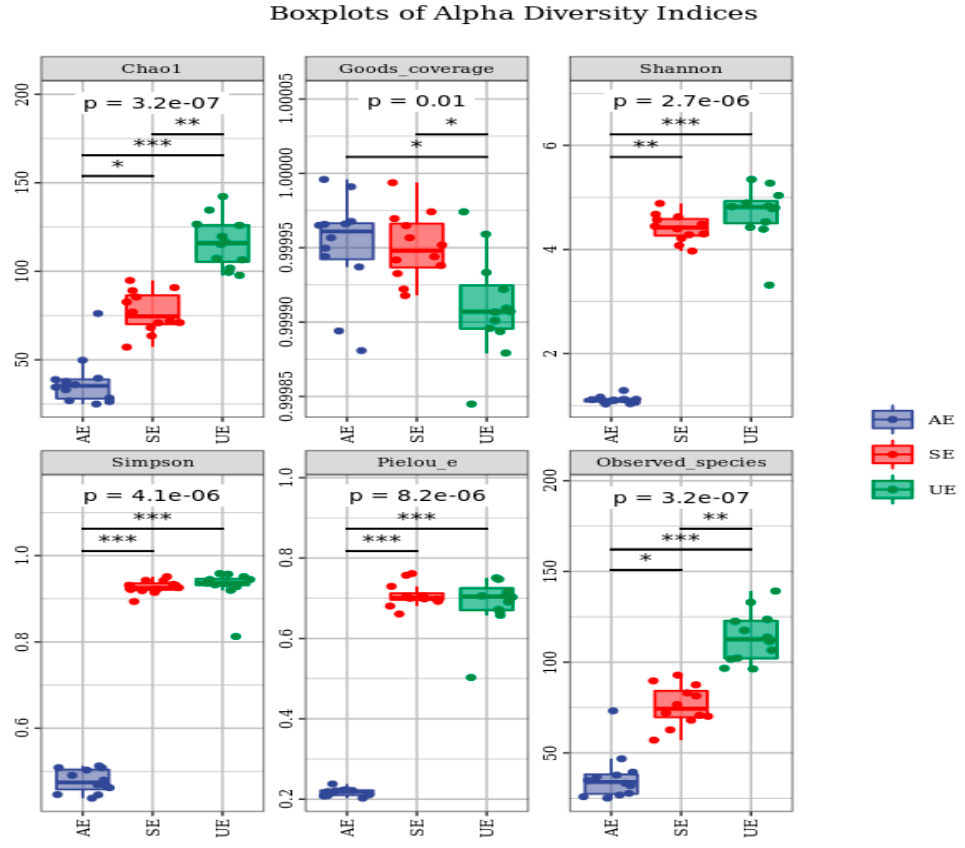
Figure 3. Seasonal difference based on the Alpha index. “*” represents p < 0.05; “**” represents p < 0.01, and “***”represents p < 0.001. Each panel corresponds to an alpha diversity index, identified by a gray area at the top. In each Panel, the abscissa is the grouping label and the ordinate is the value of the corresponding alpha diversity index; these three colors represent three reasons. The value under the diversity index label is the p value of the Kruskal–Wallis test. (Subgroup AE: Autumn of 2020. Subgroup SE: in the spring of 2021. Subgroup UE: the summer of 2021).